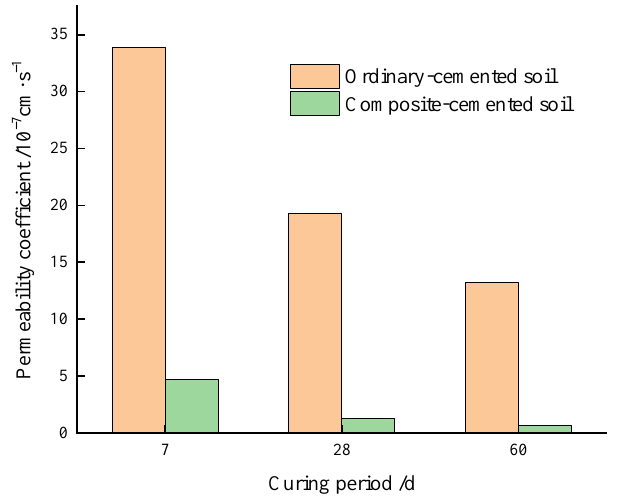
Figure 5. Comparison of permeability coefficients of different types of cemented soil after different curing periods.